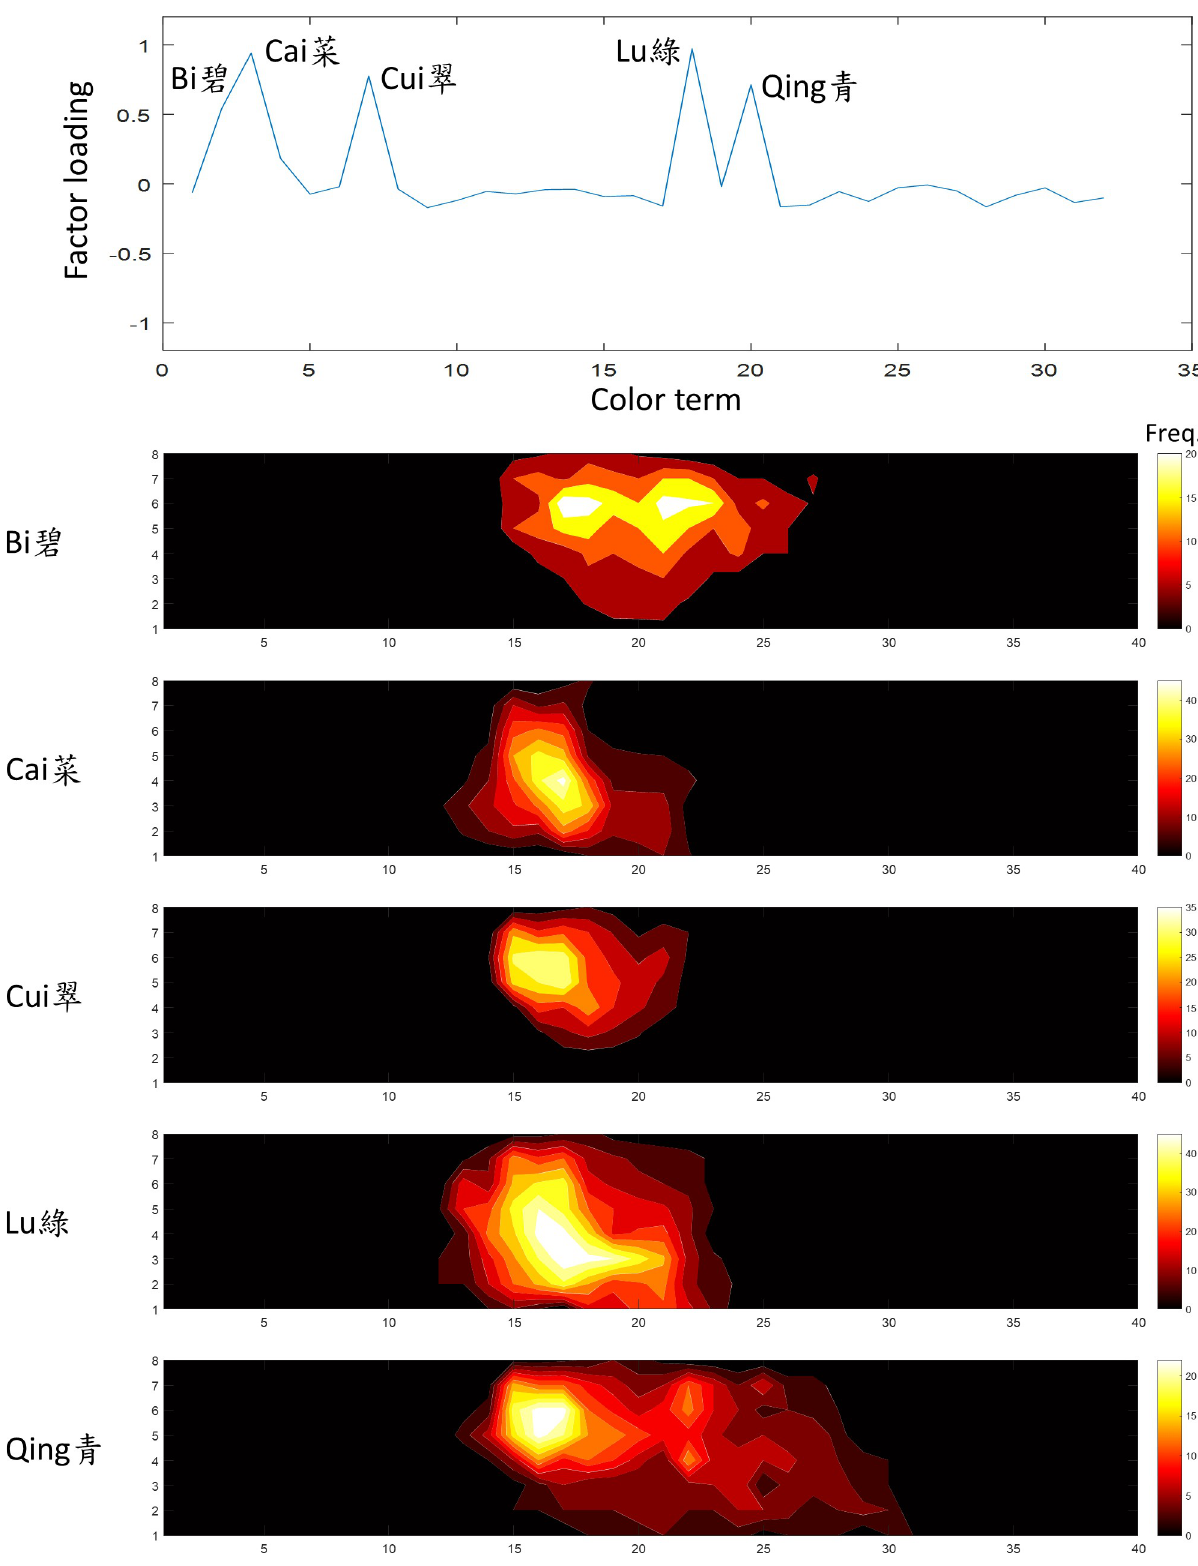
Fig 6. The second factor was “brown”. The terms He , Zong and Tu ( 褐 , 棕 , 土 )showed had high loading on this factor. The convention of the figure is the same as Fig 5. https://doi.org/10.1371/journal.pone.0206699.g006 PLOS ONE | https://doi.org/10.1371/journal.pone.0206699 November28,